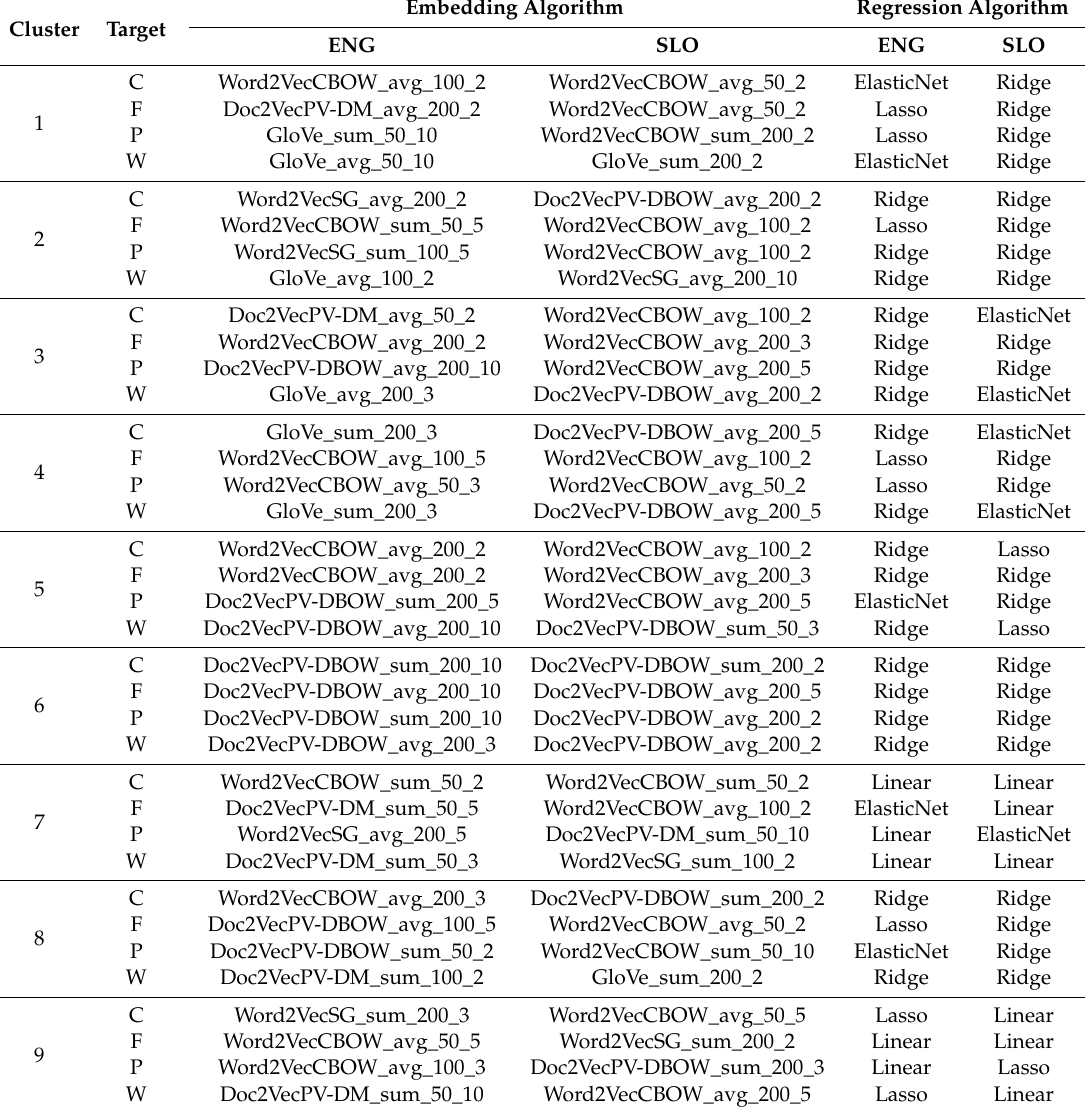
Table 7. Embedding and regression algorithms which yielded highest accuracies for each macronutrient prediction in each cluster. Target: C—Carbohydrates, F—Fat, P—Protein, W—Water. Embedding Algorithm Regression Cluster